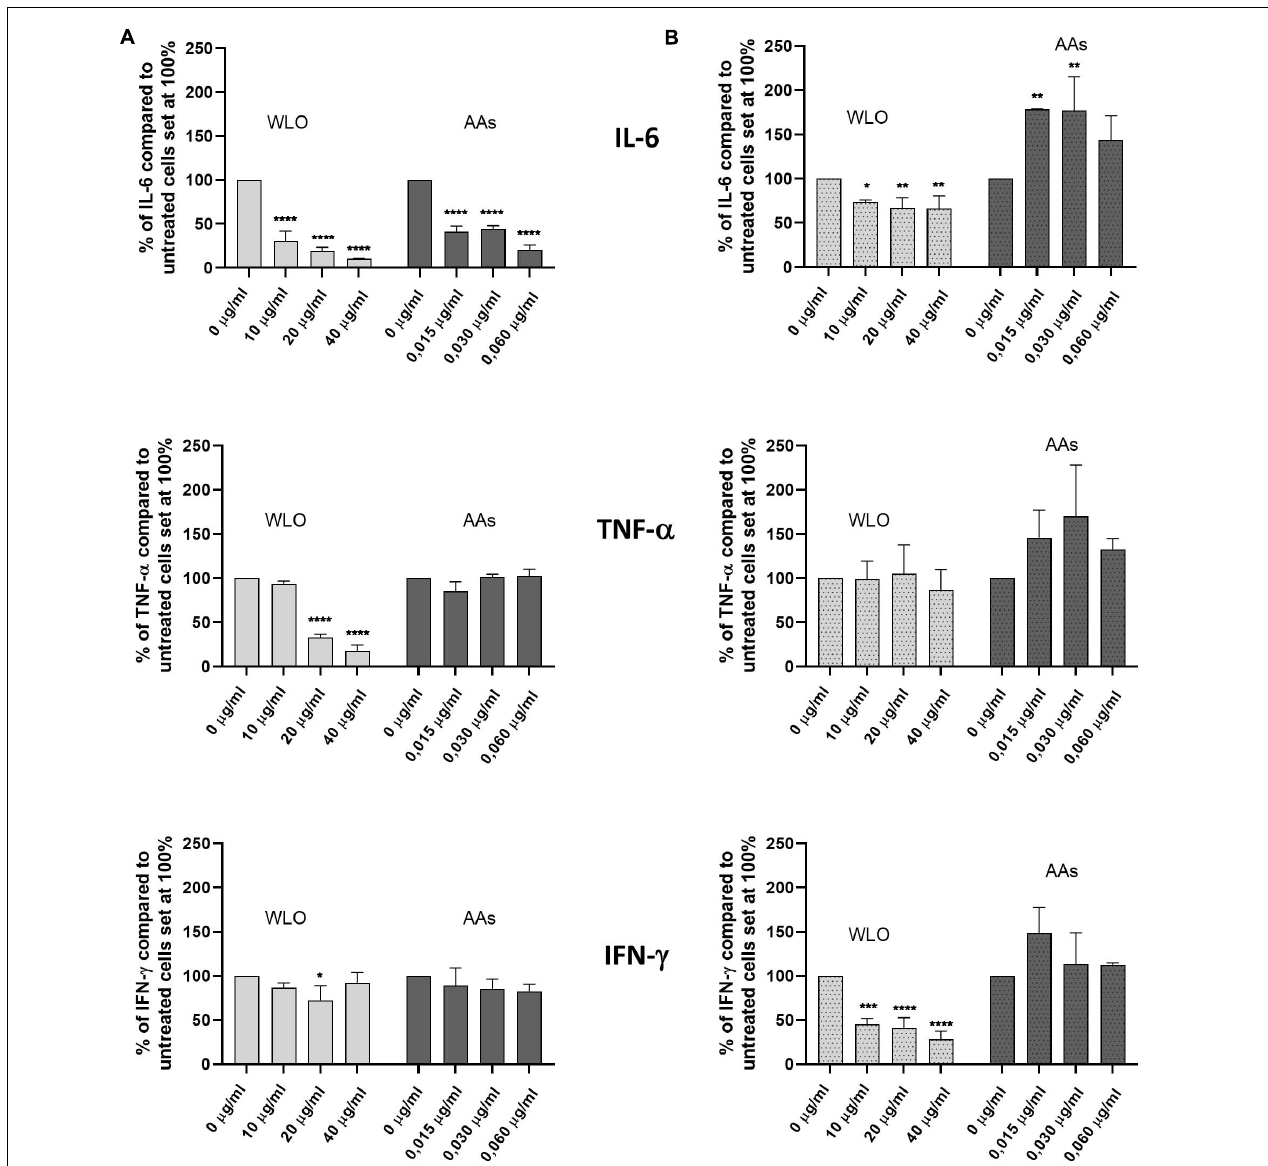
FIGURE 3 | Effects of winterized lentisk oil (WLO) and anacardic acids (AAs) on IL-6, TNF- α , and IFN- γ release from human peripheral blood mononuclear cells (h-PBMCs) in both (A) basal and (B) LPS-stimulated conditions. Statistical analysis was performed using one-way ANOVA (vs. untreated cells) (* p < 0.05, ** p < 0.01, *** p < 0.001, and **** p <